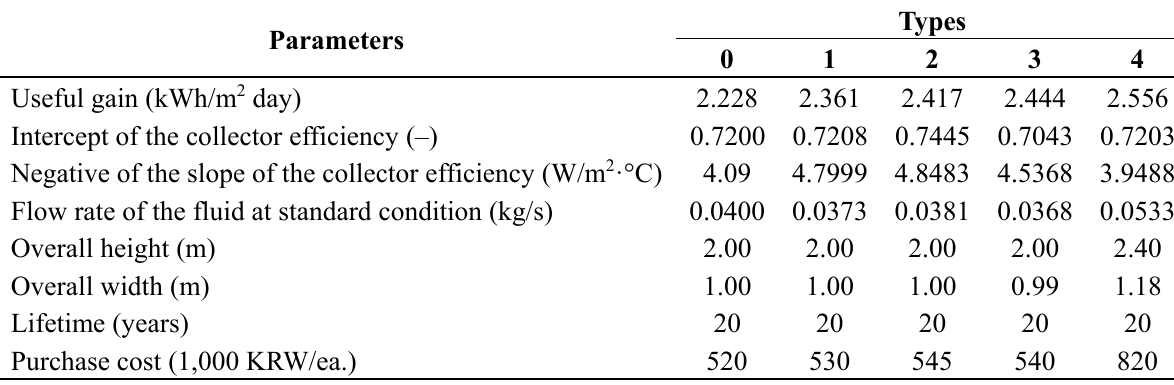
Table 1. Technical and economic parameters of the solar collectors for the case study.